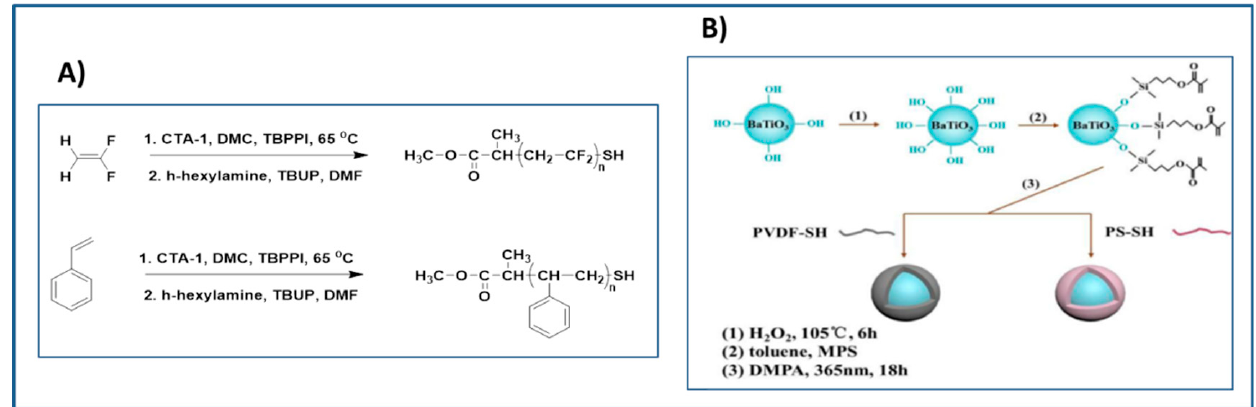
Figure 20. ( A ) Synthesis of SH-terminated PS and SH-terminated PVDF. ( B ) Grafting to approach for synthesis of hybrid nanoparticles. Reproduced with permission from Ref [131].